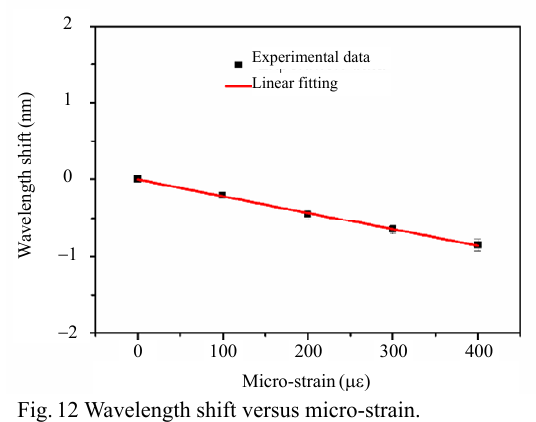
Fig. 12 Wavelength shift versus